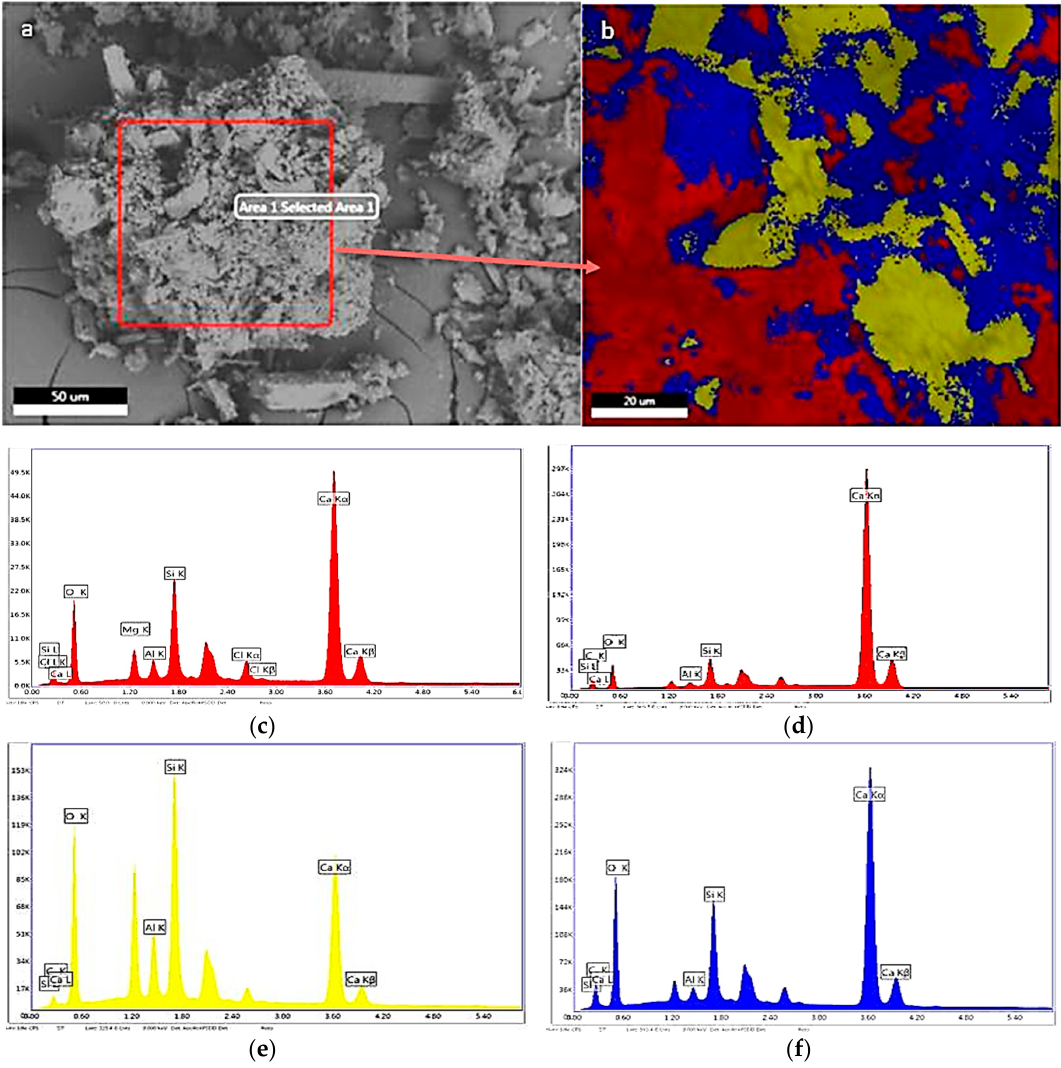
Figure 4. ( a ) scanning electron microscopy (SEM) image; ( b ) phase map of selected area; ( c ) spectrum of selected area (SA); ( d – f ) spectra of each phase represented with different colors for adhesive 1 (P1AD1). Phase distributions of selected area, SA and separate phases obtained from that area can be